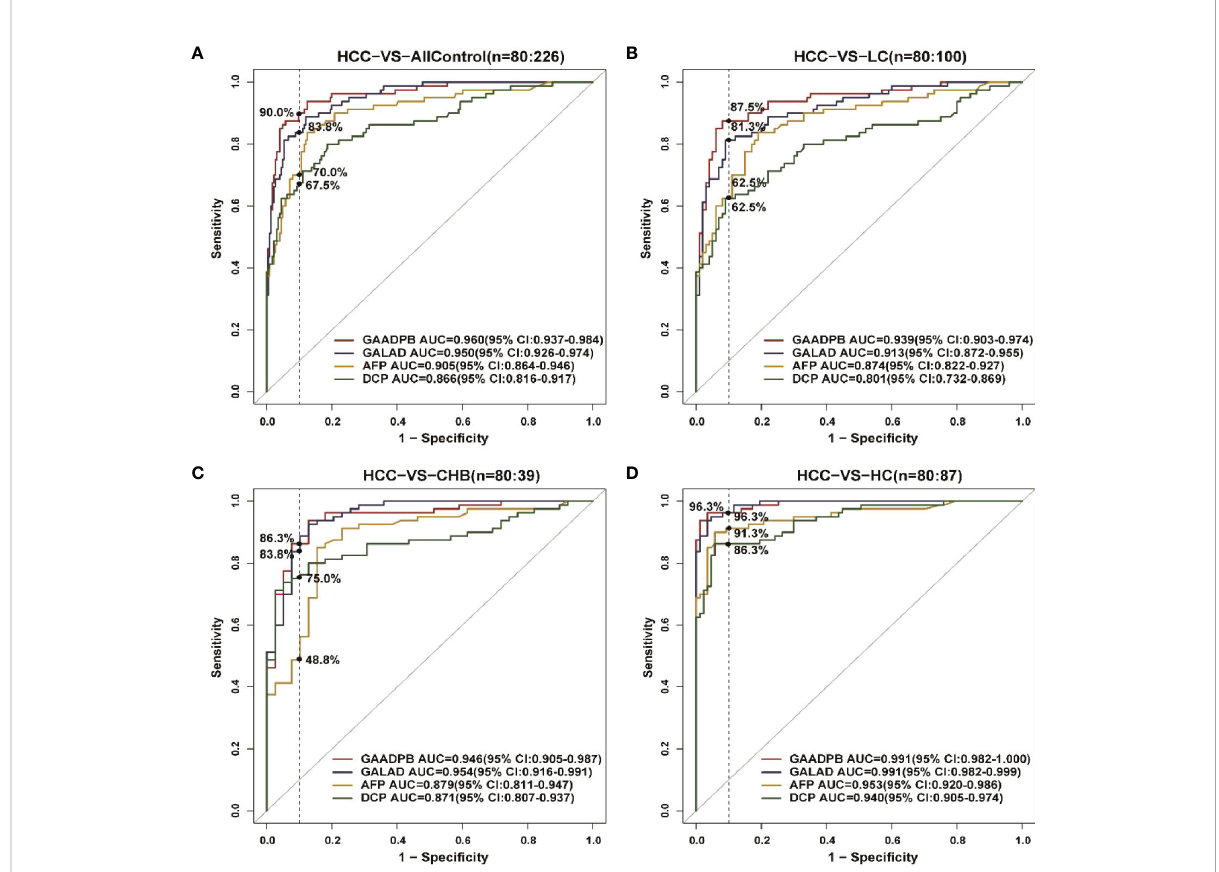
FIGURE 2 ROC curves comparing performance among GAADPB, GALAD and individual protein biomarkers for discriminating HCC from different disease subgroups and healthy controls. (A) , HCC from all control (B) , HCC from LC (C) , HCC form CHB (D) , HCC form HC. The vertical line